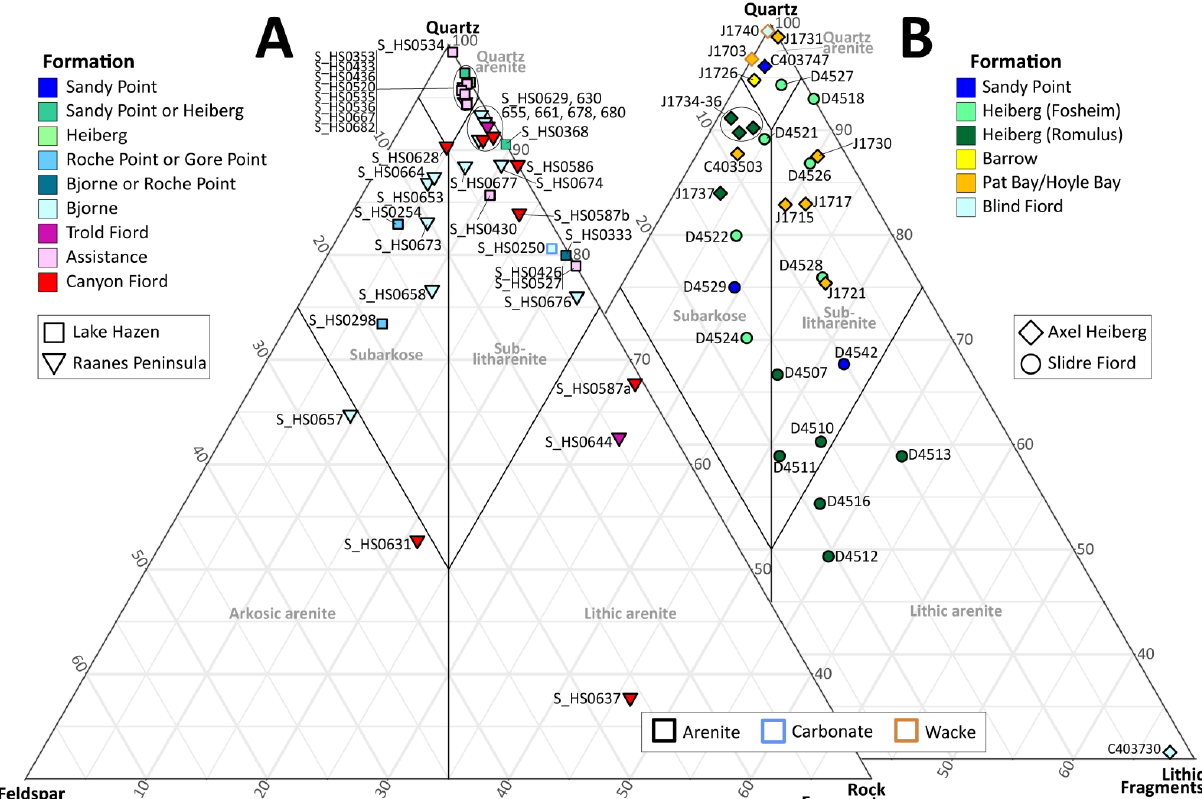
Figure 3. ( A ) Quartz–feldspar–rock fragment (QFR) ternary diagram showing point-count data collected using the traditional counting method. ( B ) Quartz–feldspar–lithic fragment (QFL) ternary diagram showing point-count data collected using the Gazzi-Dickinson method. Compositional fields are from Pettijohn et al. [89]. The figure was drawn in R using the ggtern package [102]. Note the plots are partially clipped, with the area comprising 0–30% quartz not shown.